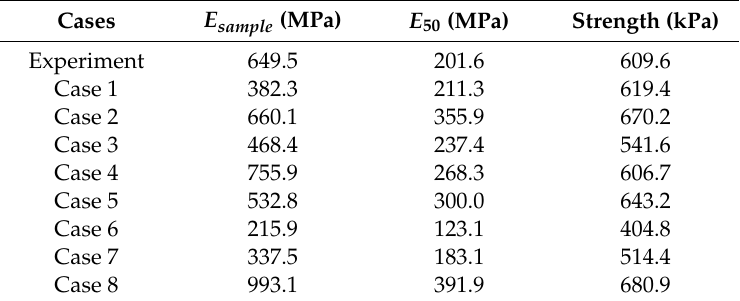
Figure 7. Comparison between DEM results and triaxial test data (confining pressure: 200 kPa): ( a ) the deviatoric stress–strain curves in Case 3 and 8; ( b ) the deviatoric stress–strain curves in Case 2 and 5; ( c ) the deviatoric stress–strain curves in Case 3, 4, and 5; and ( d ) the deviatoric stress–strain curves in Case 1, 6, 7, and 8. Table 2. Microscopic of the particle material.